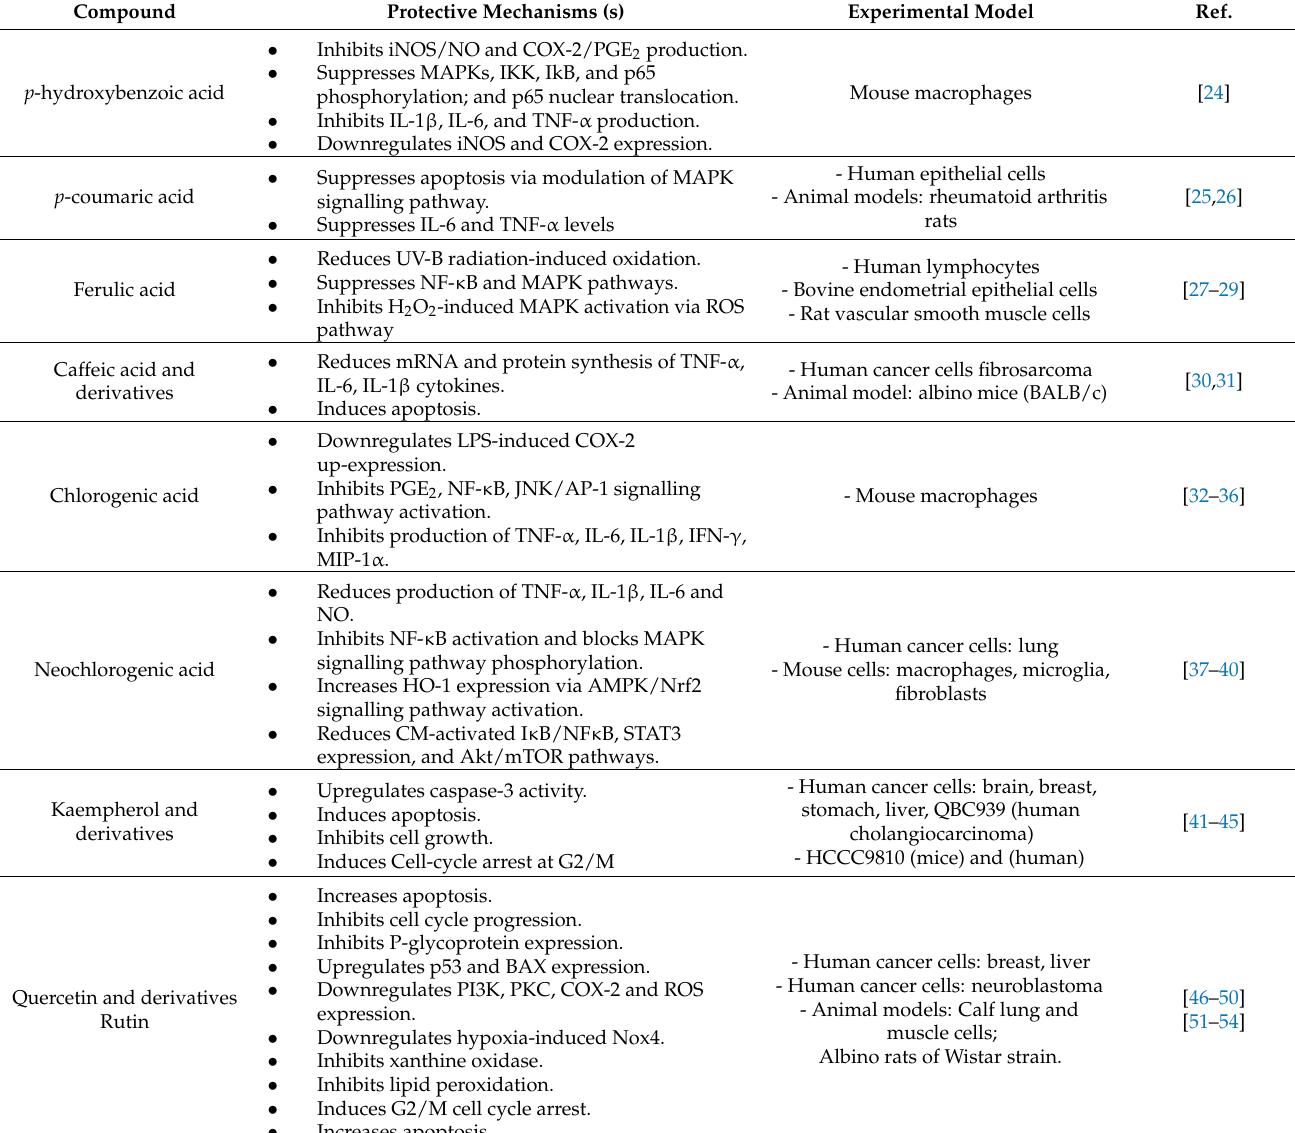
Table 3. Protective mechanisms ascribed to phenolic compounds identified in C. album berries. Experimental